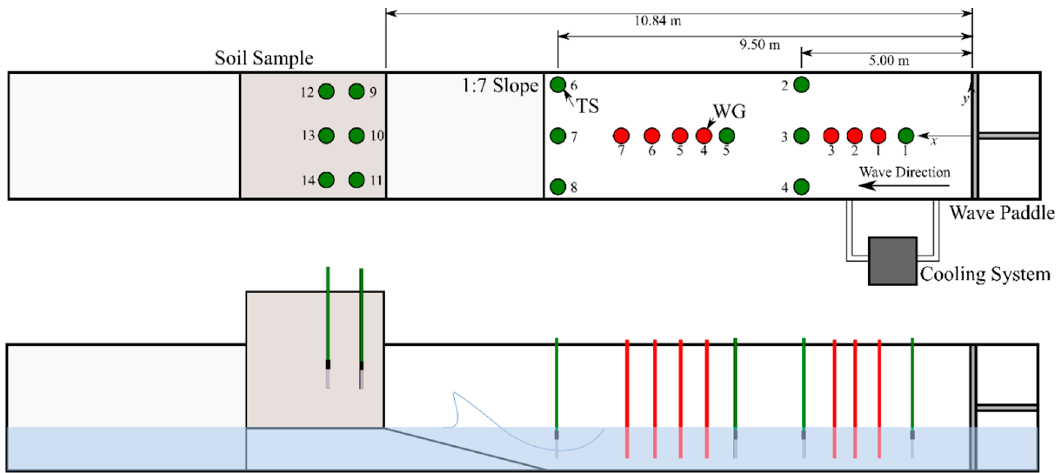
Figure 6. Wave flume (20.0 × 0.30 × 0.38 m). Wave gauges (WG) are shown as red and temperature sensors (TS) as green circles.